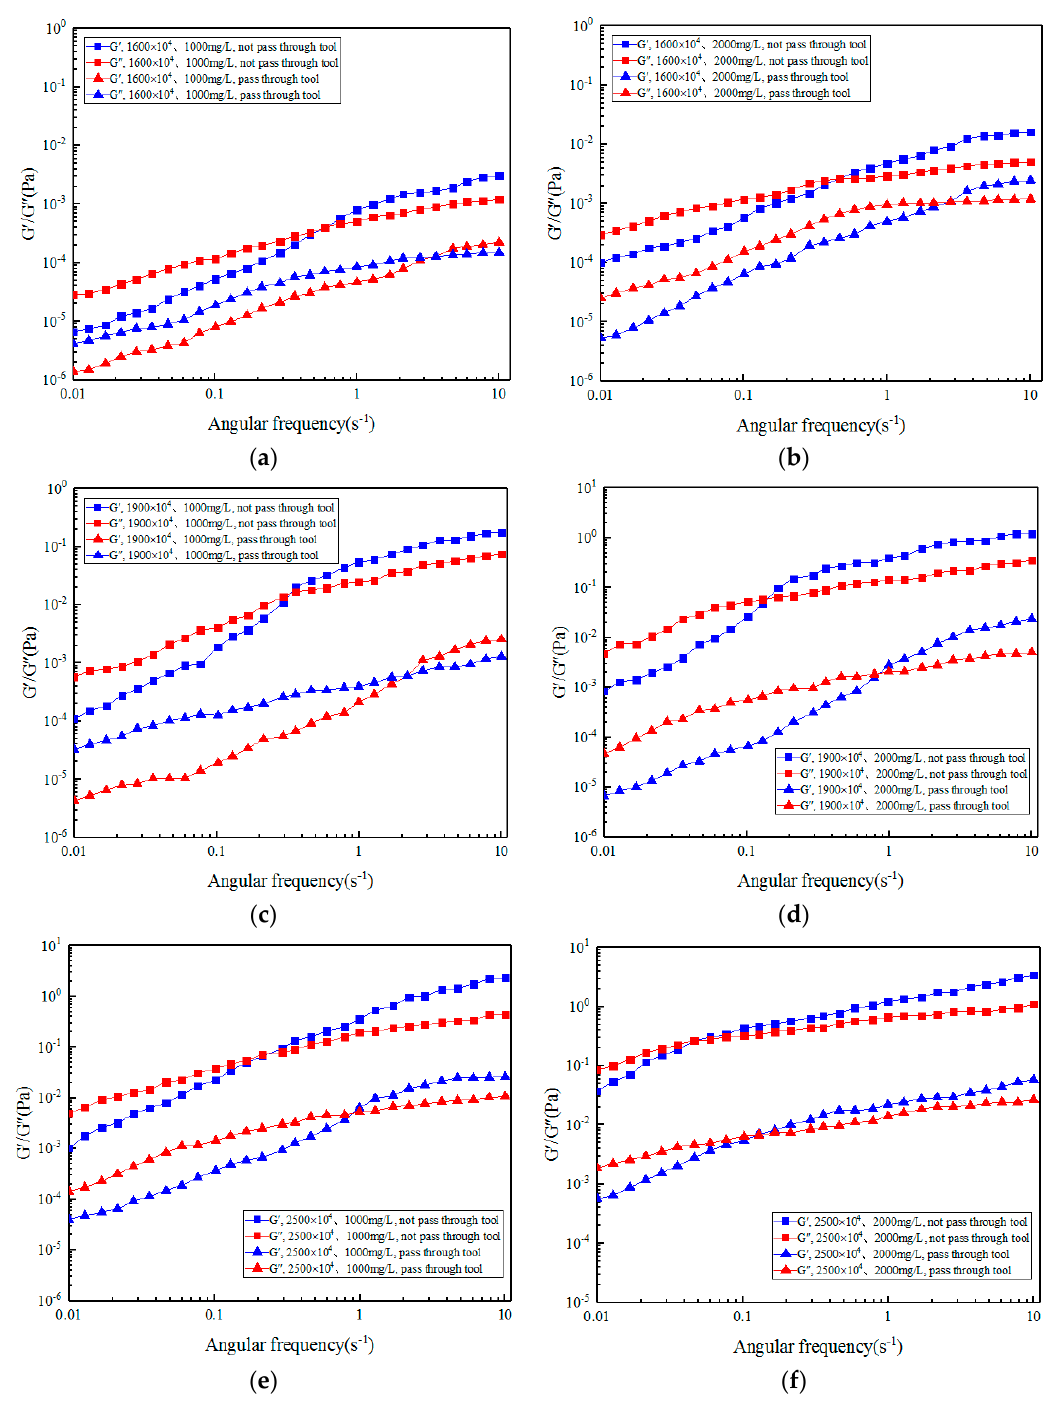
Figure 8. Variation of modulus with shear rate before and after ASP solution flowing through the different medium tool: ( a ) 16 million (MD), 1000 mg/L; ( b ) 16 million (MD), 2000 mg/L; ( c ) 19 million di ff erent medium tool: ( a ) 16 million (MD), 1000 mg / L; ( b ) 16 million (MD), 2000 mg / L; ( c ) 19 million (MD), 1000 mg/L; ( d ) 19 million (MD), 2000 mg/L; ( e ) 25 million (MD), 1000 mg/L; ( f ) 25 million (MD), (MD), 1000 mg / L; ( d ) 19 million (MD), 2000 mg / L; ( e ) 25 million (MD), 1000 mg / L; ( f ) 25 million (MD), 1000 mg/L. 1000 mg /